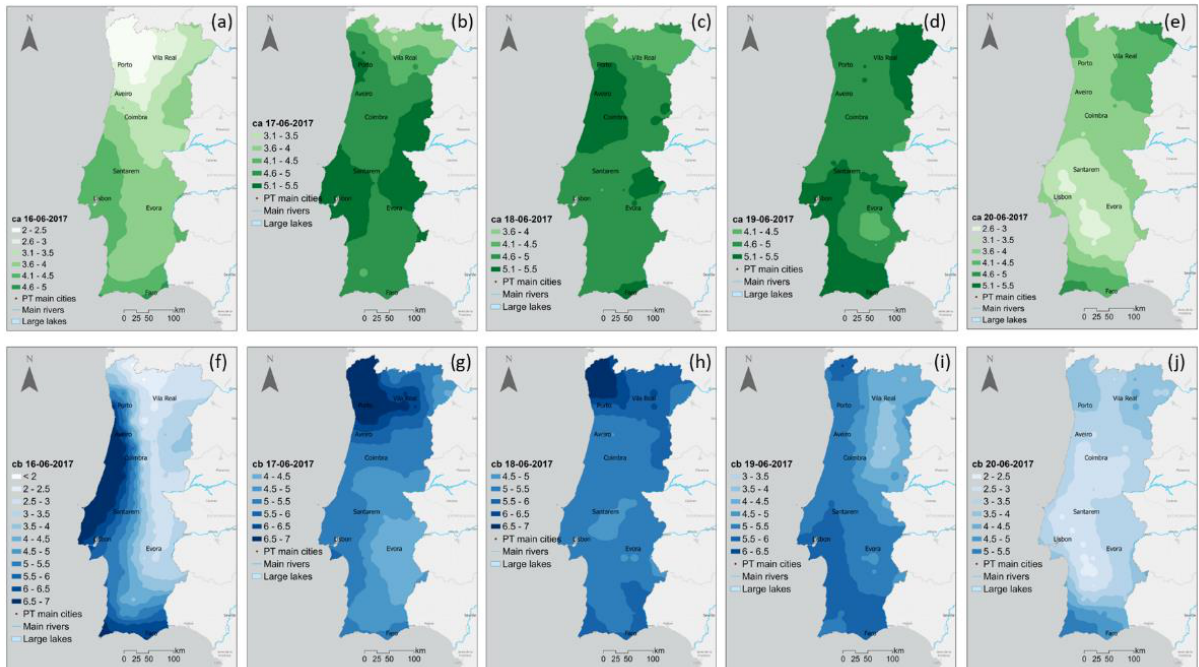
Figure A7. Daily mean values for ( a , f ) 16, ( b , g ) 17, ( c , h ) 18, ( d , i ) 19, and ( e , j ) 20 June 2017, for ca (upper row) and cb (lower row) (Note that ca was attained by (1) and cb by (2), see Section 2.2.2 for further details).